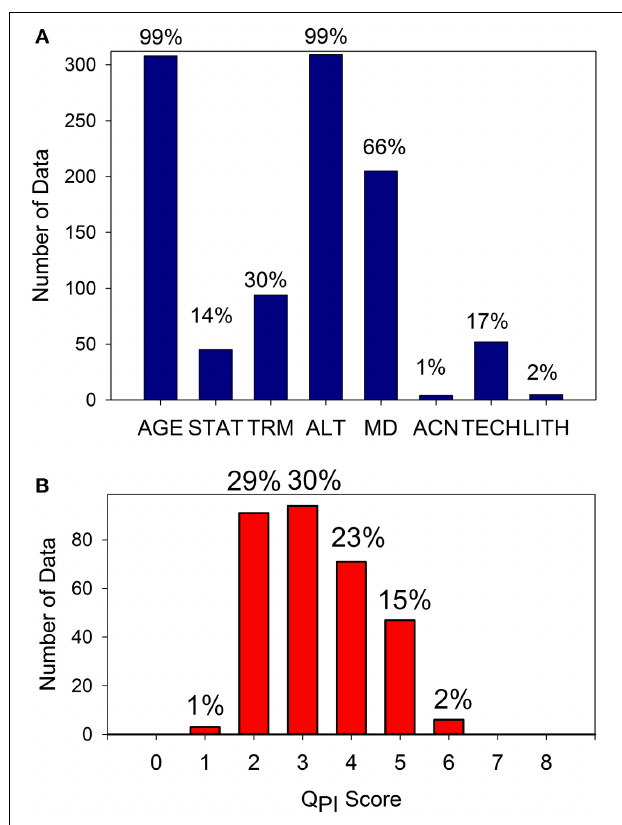
FIGURE 1 | Breakdown of (A) individual criteria and (B) Q PI values by number of virtual (axial) dipole moment estimates in the 2012.08 and 2014.01 updates to